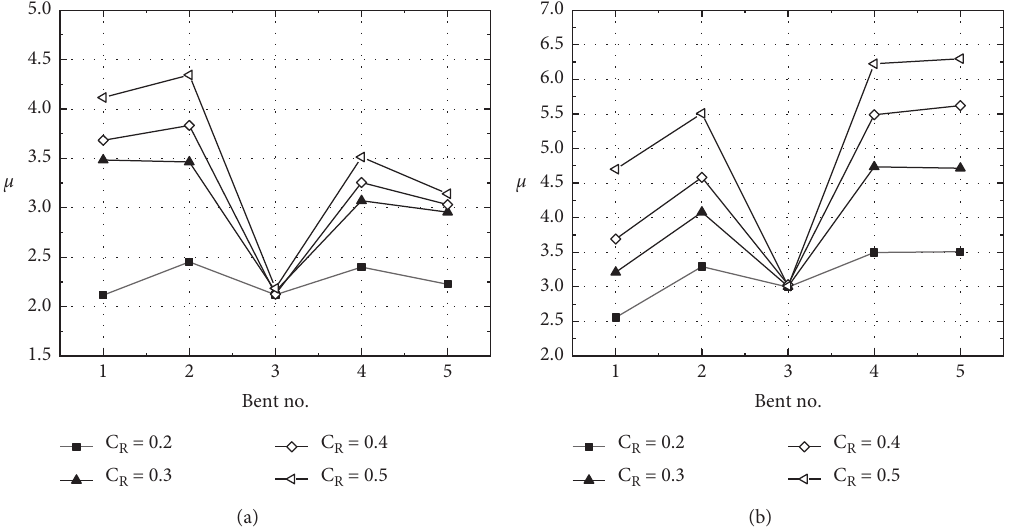
Figure 19: Effect of C R on the displacement ductility demands. (a) Longitudinal direction. (b) Transverse